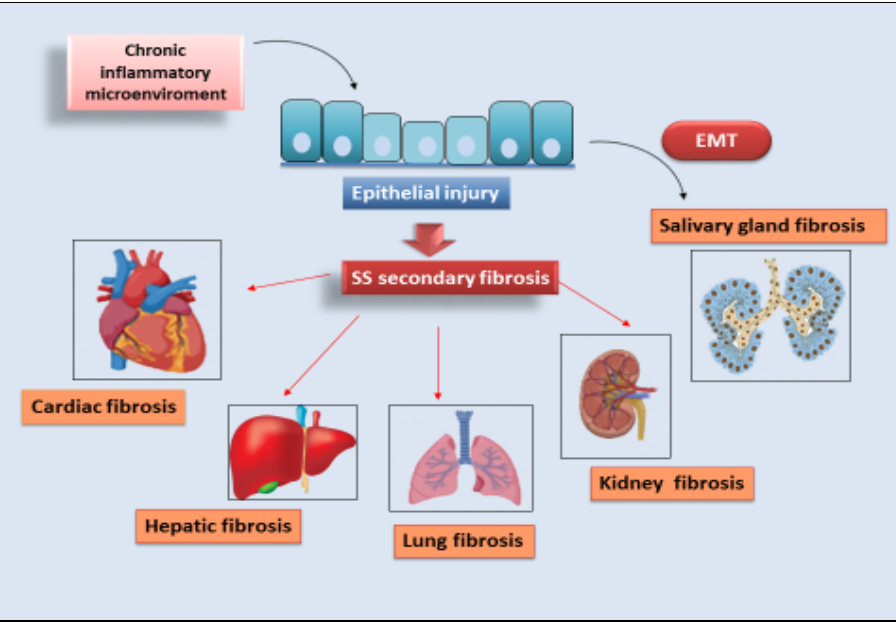
Figure 2. Secondary organ fibrogenesis in SS . Chronic inflammatory microenvironment cooperates for the progression of organ fibrosis in SS patients. Injury events lead to organ damage, inflammation, and fibrosis in the liver, kidney, lung, heart, and SGs.